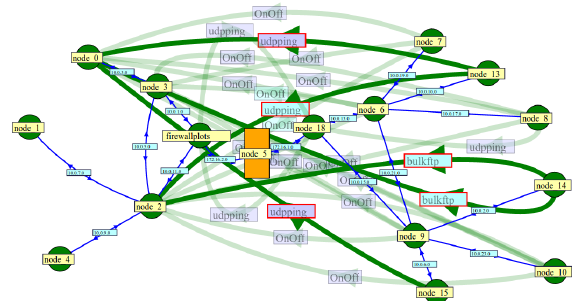
Fig. 1. An Example network with a firewall router